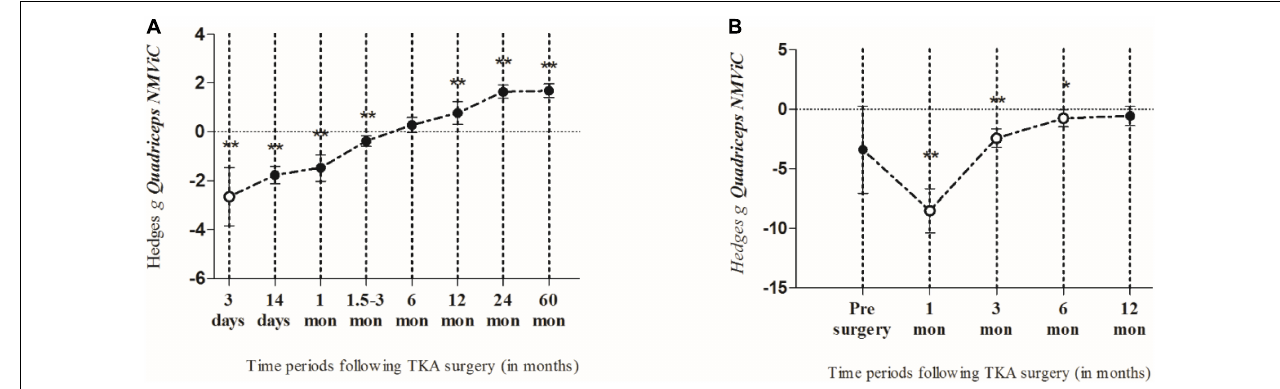
FIGURE 3 | The summarized effects of more than one effect size (closed circles) and one effect size only (open circles), demonstrating the time course of quadriceps muscle maximal voluntary isometric strength normalized by body weight (NMViC) (A) comparison of pre to post within patients and (B) compared with healthy age-matched controls. Data are presented as effect sizes and lower and upper limits of 95% confidence interval.